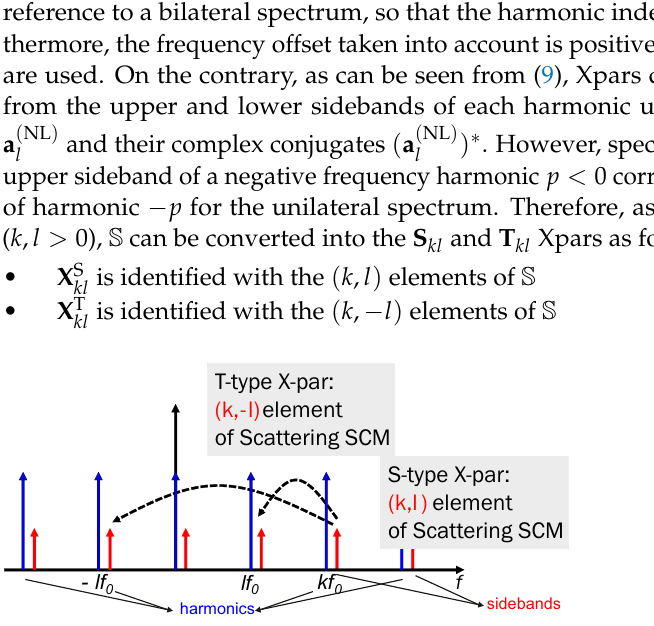
Figure 10. Extraction of X-parameters from the scattering sideband conversion